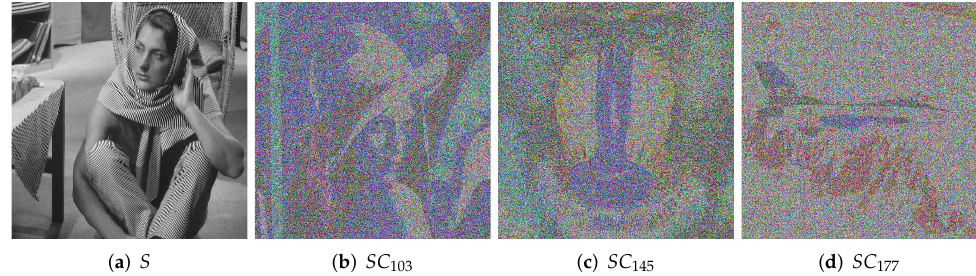
Figure 9. Thumbnail Secret Sharing of color